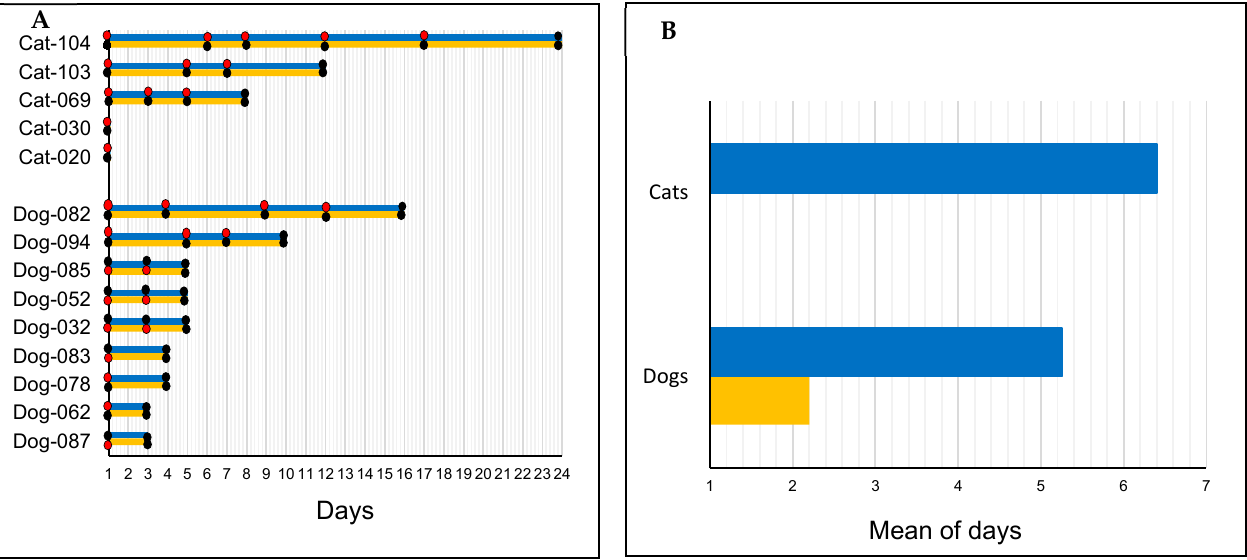
Figure 3. Duration of SARS-CoV-2 detection in dogs and cats from COVID-19+ households in Congo. ( A ) Duration of detection in dogs and cats. ( B ) Comparative mean duration of detection in nasopharyngeal and rectal samples from pets. Black dot—negative result; red dot—positive result; blue line—nasopharyngeal sample; and yellow line—rectal sample.